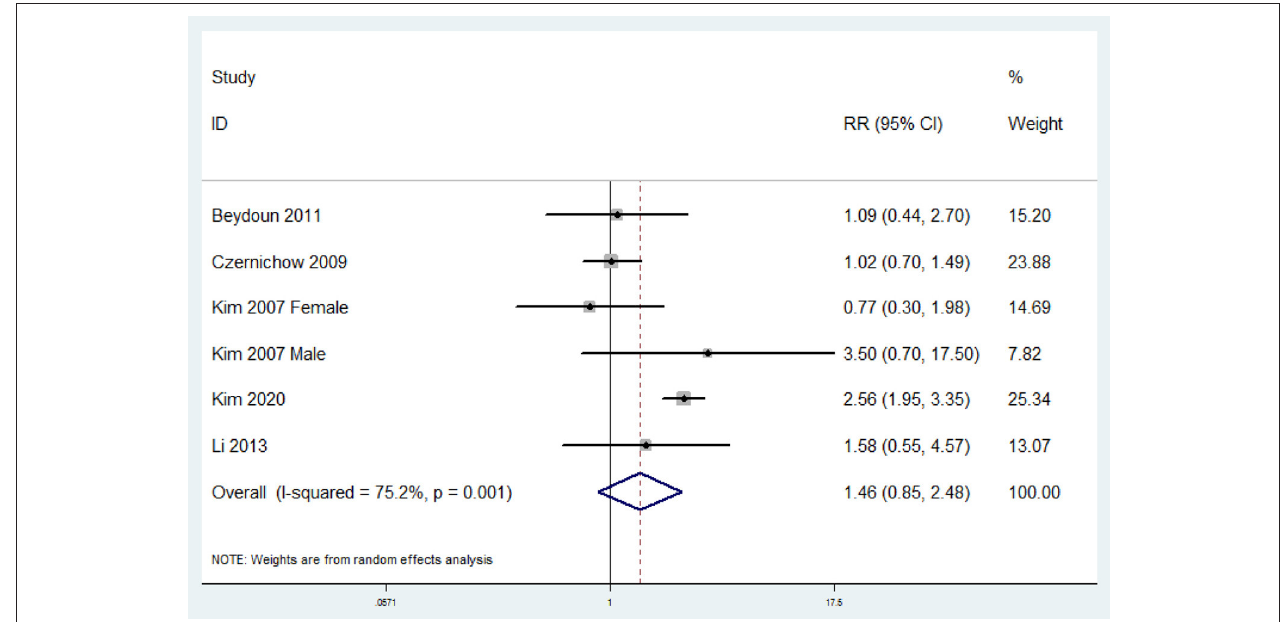
FIGURE 4 | Forest plot of meta-analysis: Overall multi-variable adjusted RR of MetS for the highest vs. lowest category of circulating vitamin E level.